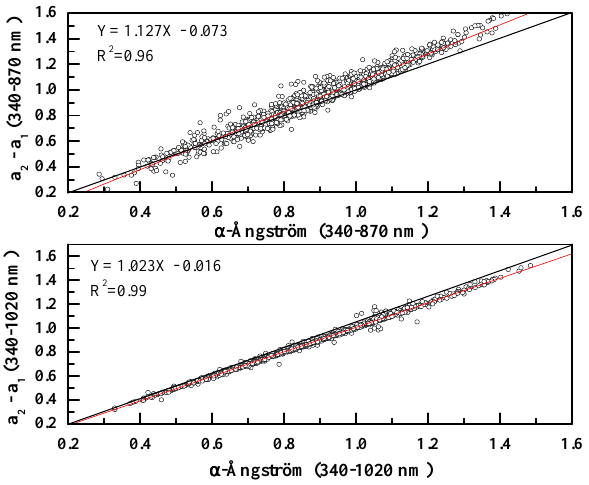
Fig. 5. Correlation between the differences a 2 – a 1 and the α values in two different spectral bands. The black lines represent the y - x condition and the red line the linear equation given in the graph.